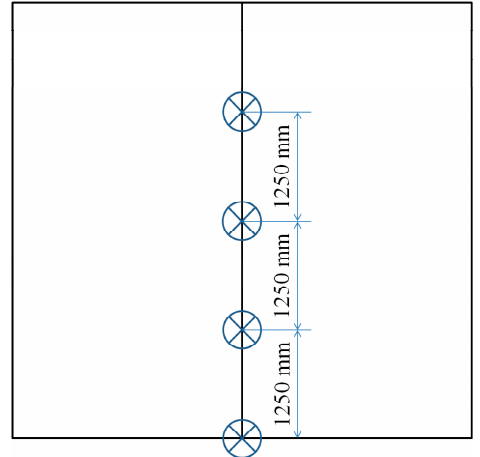
Figure 3. Schematic diagram of pressure box arrangement.